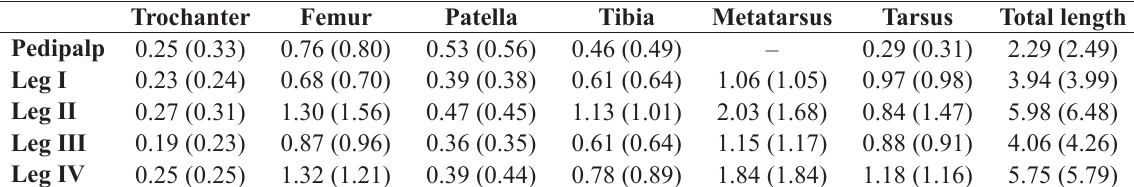
Table 1. Length of appendage-segments in millimeters in N. bidentatum bidentatum Roewer, 1914 from Ljubelj, Slovenia: ♂ (♀).